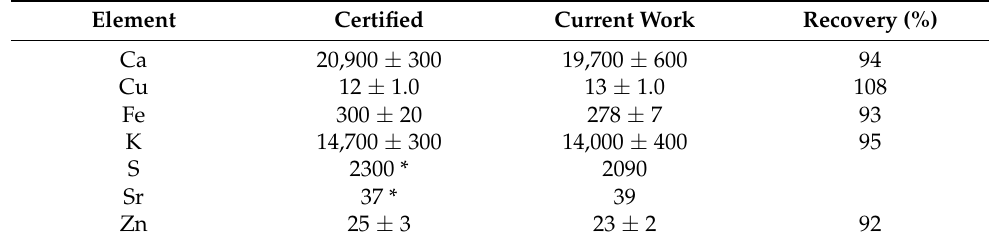
Table 6. Elemental concentration present in certified standard samples (Orchard leaves -SRM 1571).